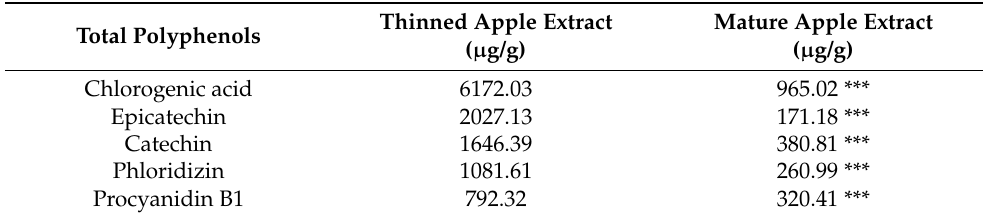
Table 2. Polyphenol contents of thinned and mature apple